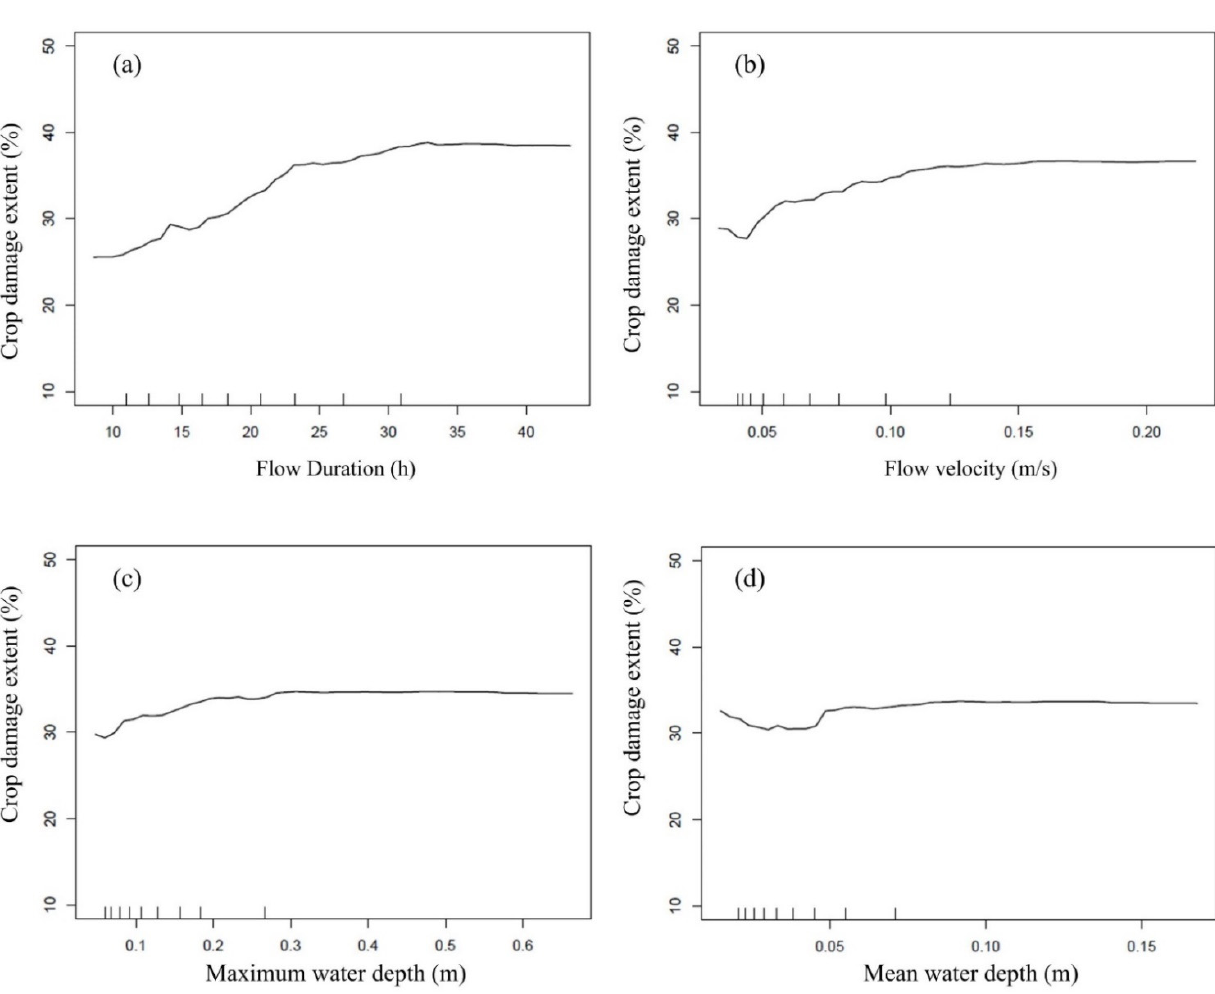
Figure 7. The relationship between ( a ) flow duration, ( b ) flow velocity, ( c ) maximum water depth, ( d ) mean water depth and crop damage extent detected by the random forest model. The predictors are sorted by their importance.